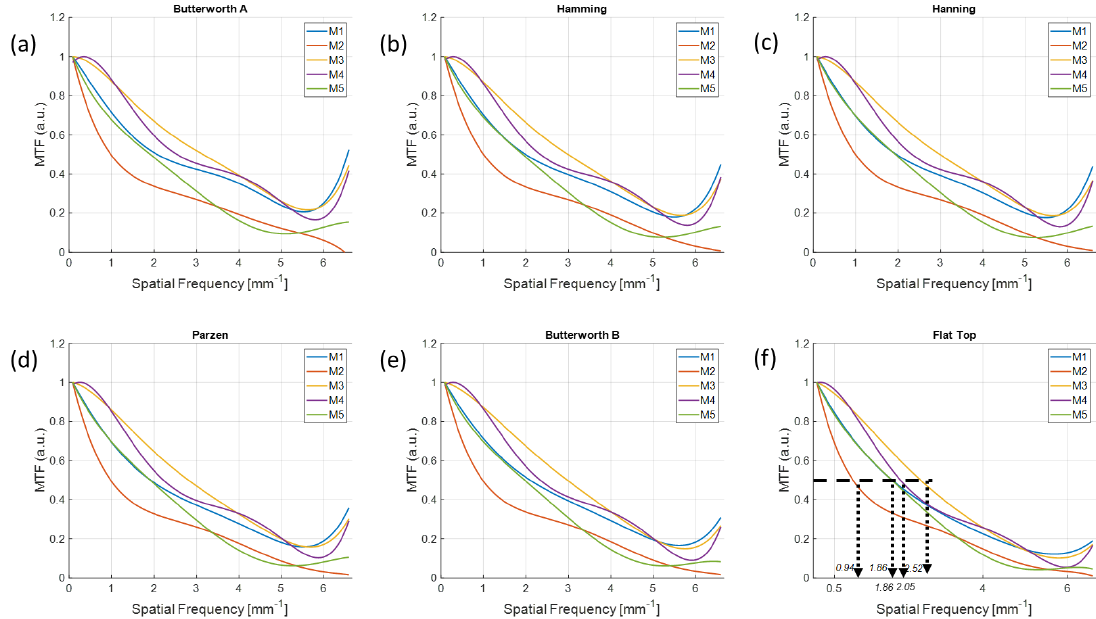
Figure 11. MTFs for different materials with the configurations (2, 2) using different filter schemes from the ( a ) Butterworth A, ( b ) Hanning, ( c ) Hamming, ( d ), Parzen, ( e ) Butterworth B, and ( f ) Flat Top windows. The order of f 50 s as a function of different materials was M3, M4, M1, M5, and M2.